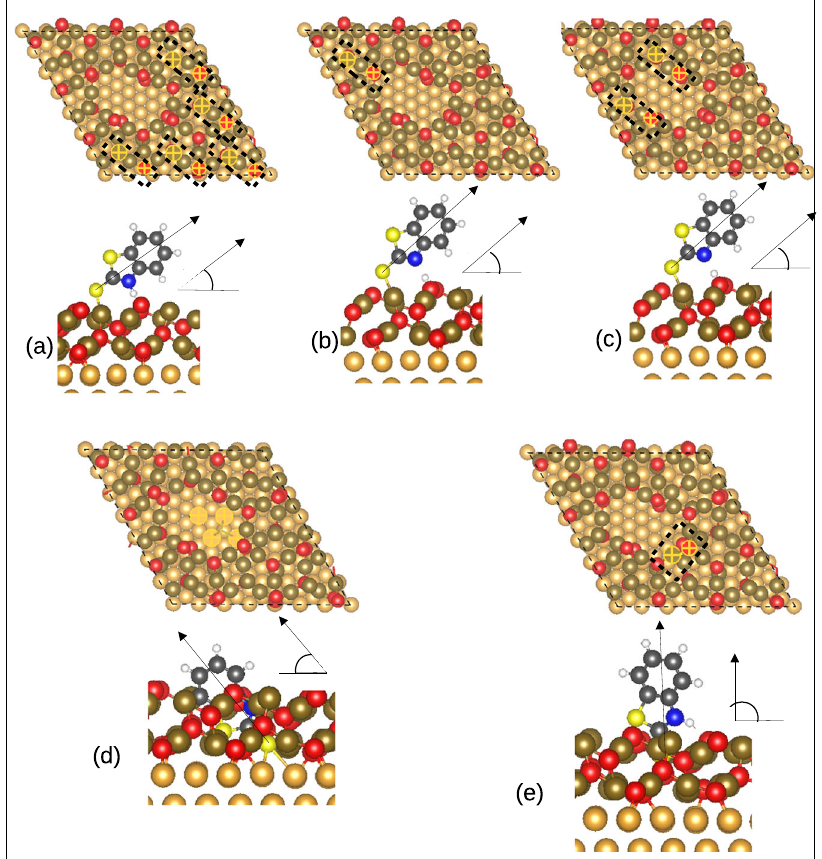
Fig. 5 Different snapshots of MBTH adsorbed on different parts of partially oxide-covered copper surface. a and b Illustrate adsorption of MBTH on the oxide surface, c on the oxide edges, d on metal surface (con fi guration 1), and e on the oxide wall (con fi guration